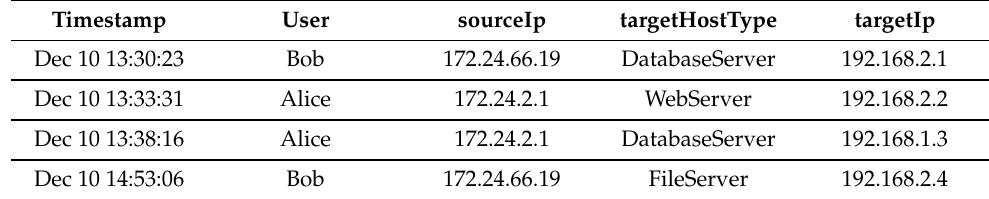
Table 2. SSH connections query result